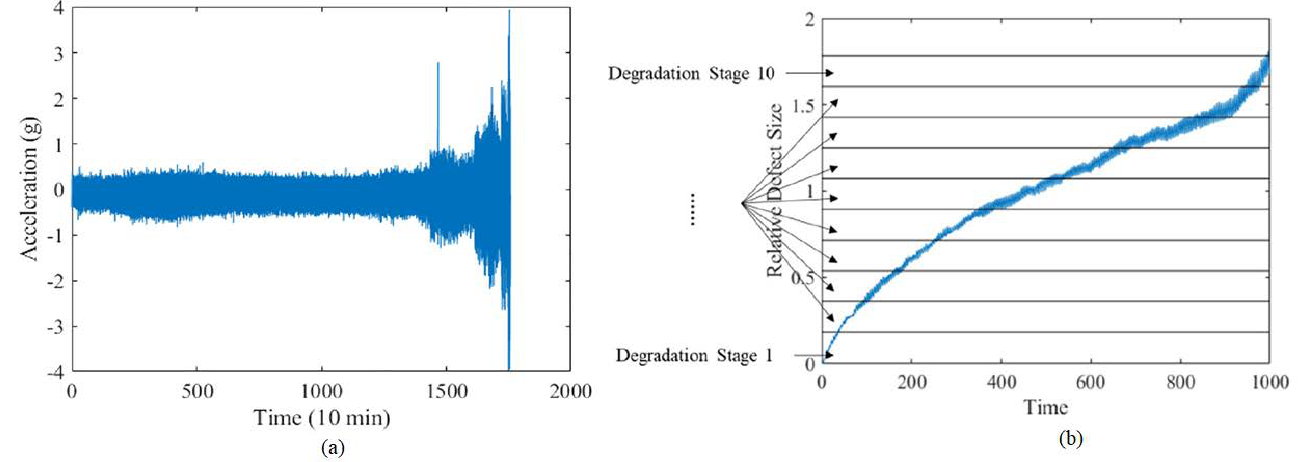
Figure 53. ( a ) Test data of bearing lifetime. ( b ) Degradation stages based on experimental data [130].